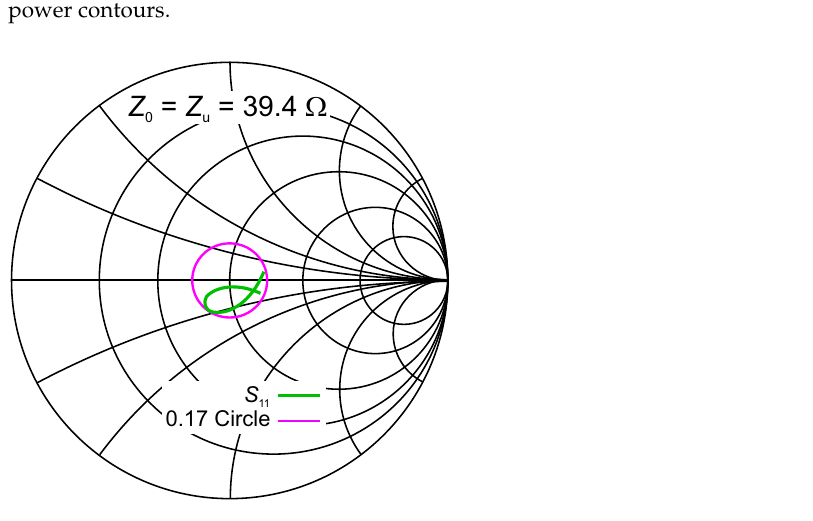
Figure 7. Result of the simulation of Figure6 superimposed to the target circle with radius 0.17.